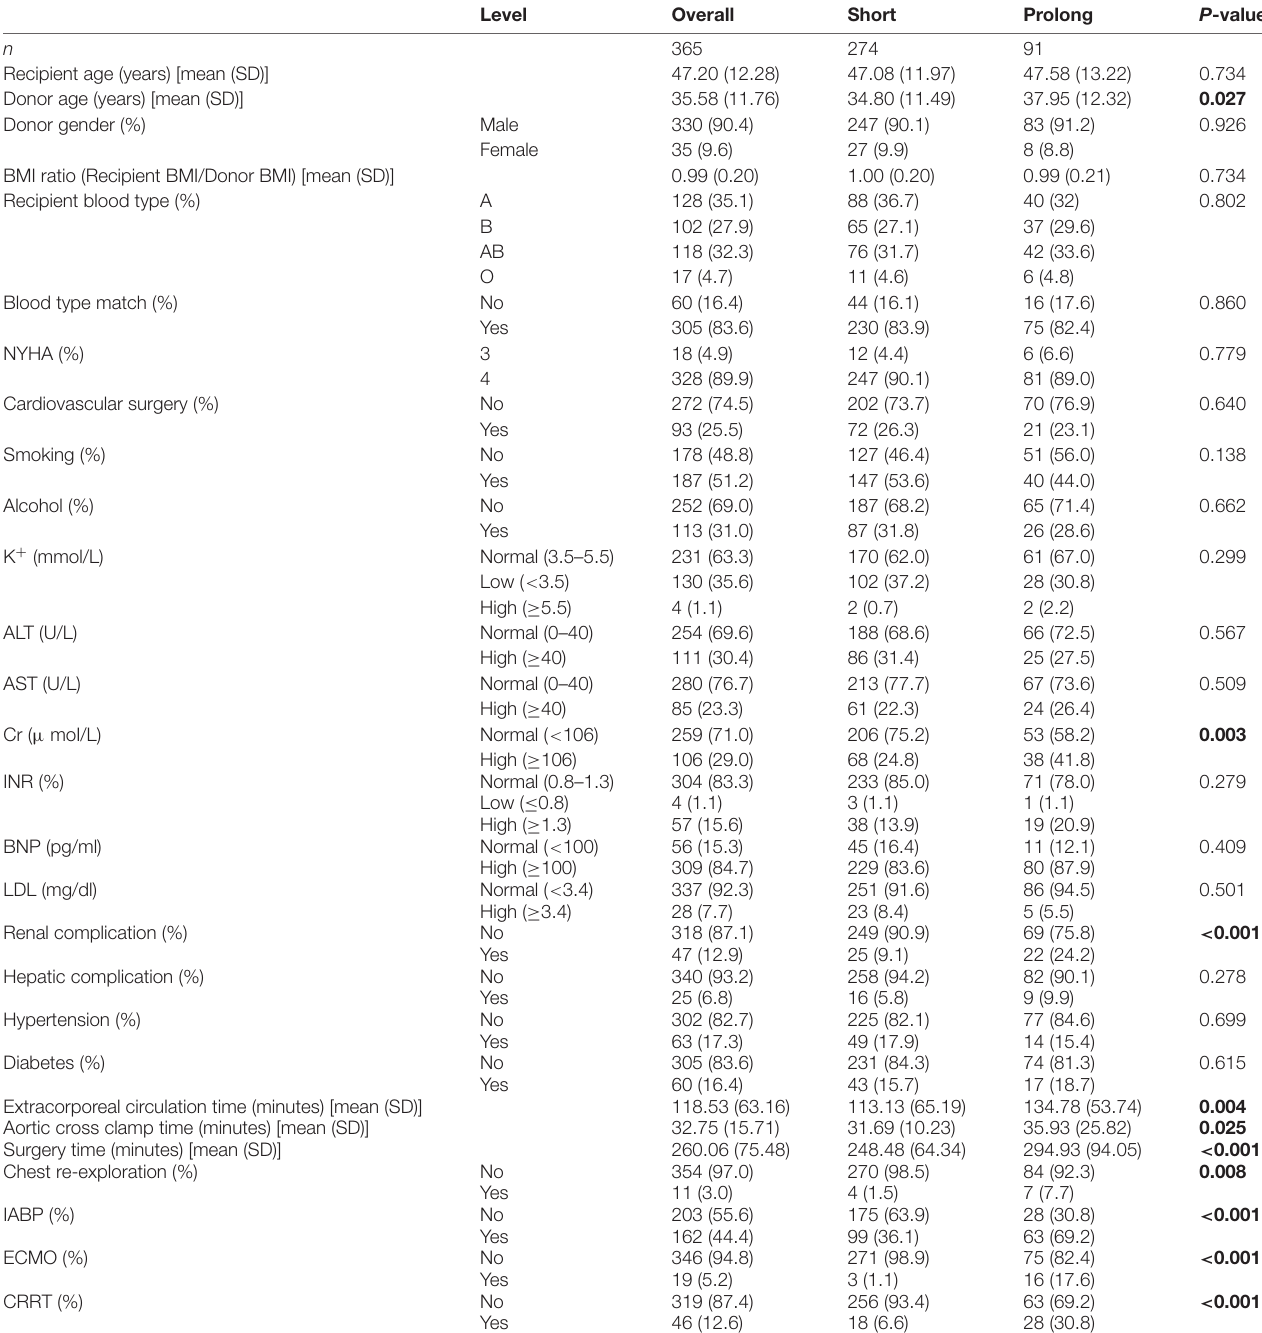
TABLE 1 | Baseline